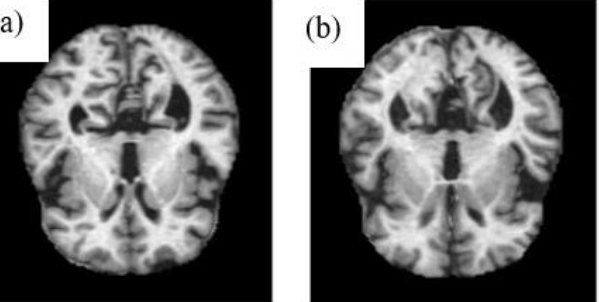
Figure 1. MRI images of ( a ) the brain of a healthy person ( b ) the brain of a person suffering from dementia. Several classification methods for AD have recently been reported. Calhoun et al. and Guo et al. reviewed Alzheimer’s disease classification based on MRI data [9,10].